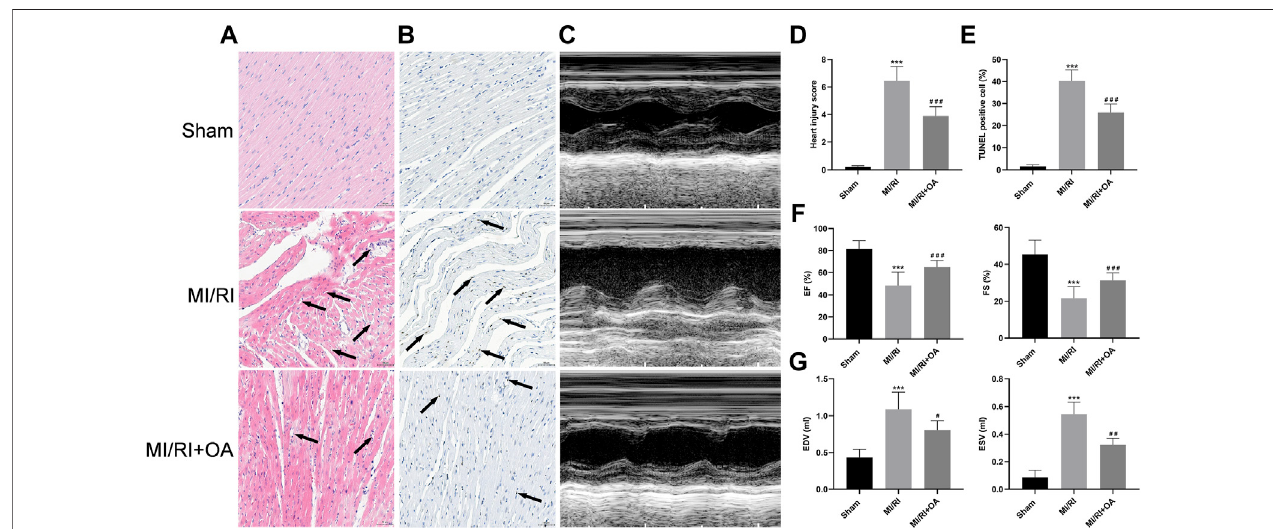
FIGURE 6 | OA treatment ameliorates cardiac function against MI/RI (A,D) Representative H&E staining images and quantitative analysis for heart tissues in each group (scale bar = 50 μ m). Arrows indicate edema and in fl ammation cell in fi ltration (B,E) Representative TUNEL staining images and quantitative analysis for heart tissues in each group (scale bar = 50 μ m). Arrows indicate representative apoptotic positive cells (C,F,G) Representative Echocardiography images and quantitative analysisofEF,FS,EDV,ESVforhearttissuesineachgroup.Dataarepresentedasthemean±SD. p p < 0.05,comparedwiththeShamgroup; # p < 0.05,compared withtheMI/RIgroup.MI/RI:myocardialischemia/reperfusioninjury;OA:OroxinA;H&E:hematoxylinandeosin;TUNEL:Terminal-deoxynucleotidyltransferase-mediated nick end labeling; EF: ejection fraction; FS: fractional shortening; EDV: end diastolic volume; ESV: end systolic volume.